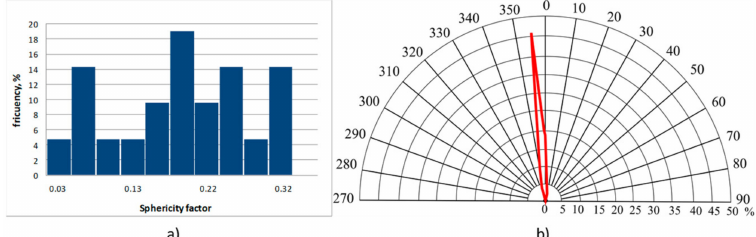
Figure 15. ( a ) Distribution of olivine grains according to the sphericity coe ffi cient and ( b ) the orientation of the longest axis in grade